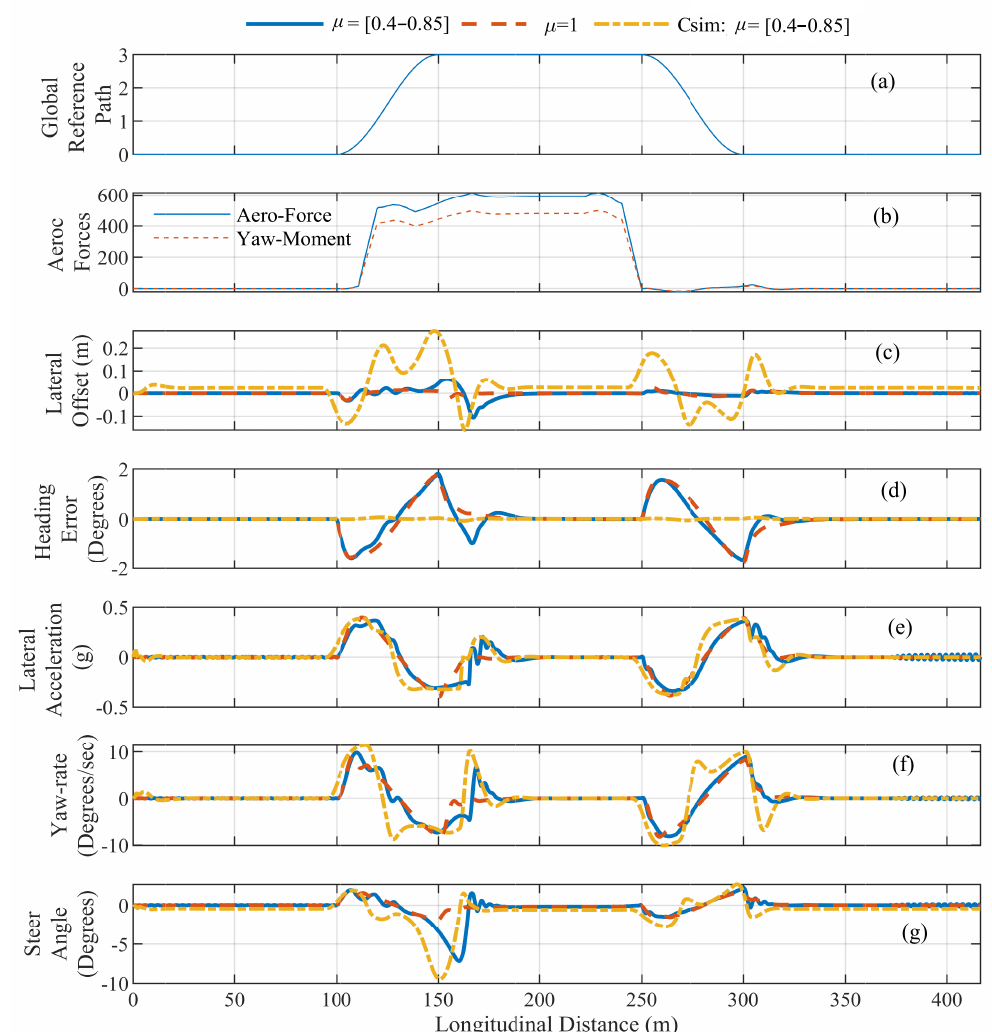
Figure 8. Lane keeping and vehicle stability performance of the proposed RBFNN-HOSM controller for v x = 100 km/h in the presence of disturbances and a variety of road conditions and comparison with the in-built Carsim vehicle simulator, µ ∈ [ 0.4–0.85 ] and µ = 1. ( a ) Global Reference Path, ( b ) Aero forces, ( c ) Lateral Offset, ( d ) Heading Error, ( e ) Lateral Acceleration, ( f ) Yaw Rate, ( g ) Road Steer Angle for various road